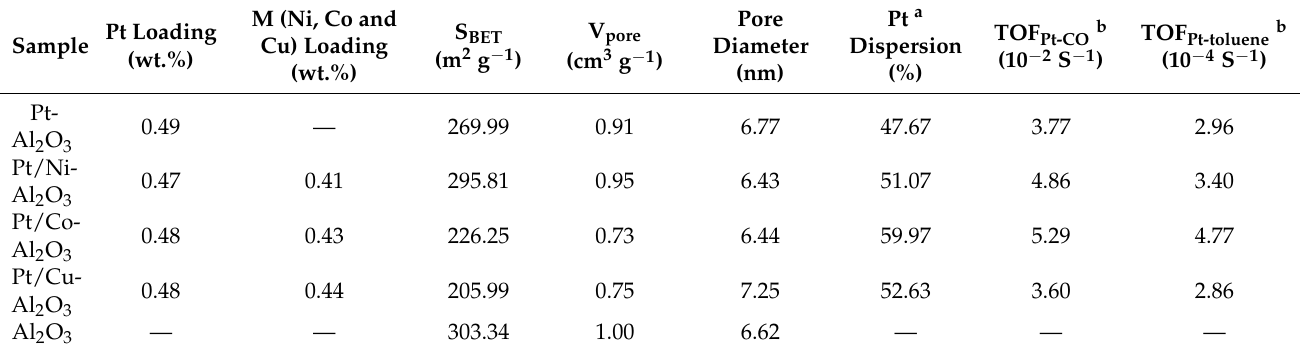
Figure 1. ( a ) N 2 adsorption/desorption isotherms and ( b ) pore-size distributions for Al 2 O 3 , Pt/Al 2 O 3, and Pt-M/Al 2 O 3 samples. Table 1. Elemental compositions, surface area data, and other physical-chemical parameters of Pt-Al 2 O 3 and Pt/M-Al 2 O 3 samples.